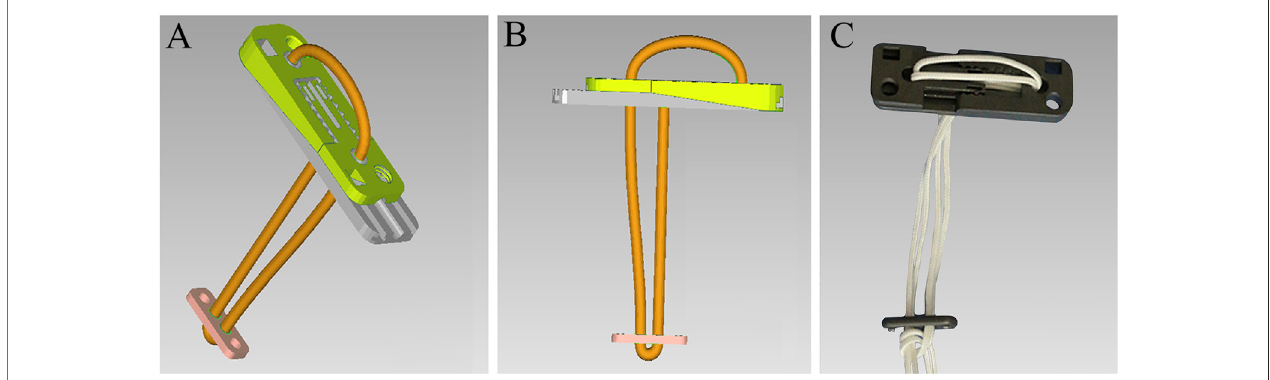
FIGURE 2 | Virtual 3D models of the NAE (A) and (B) and real product (C)